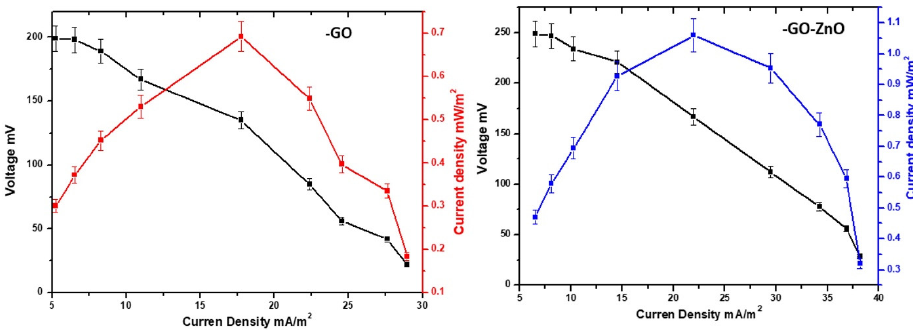
Figure 6. Polarization curves of GO and GO-ZnO anode during the operation.